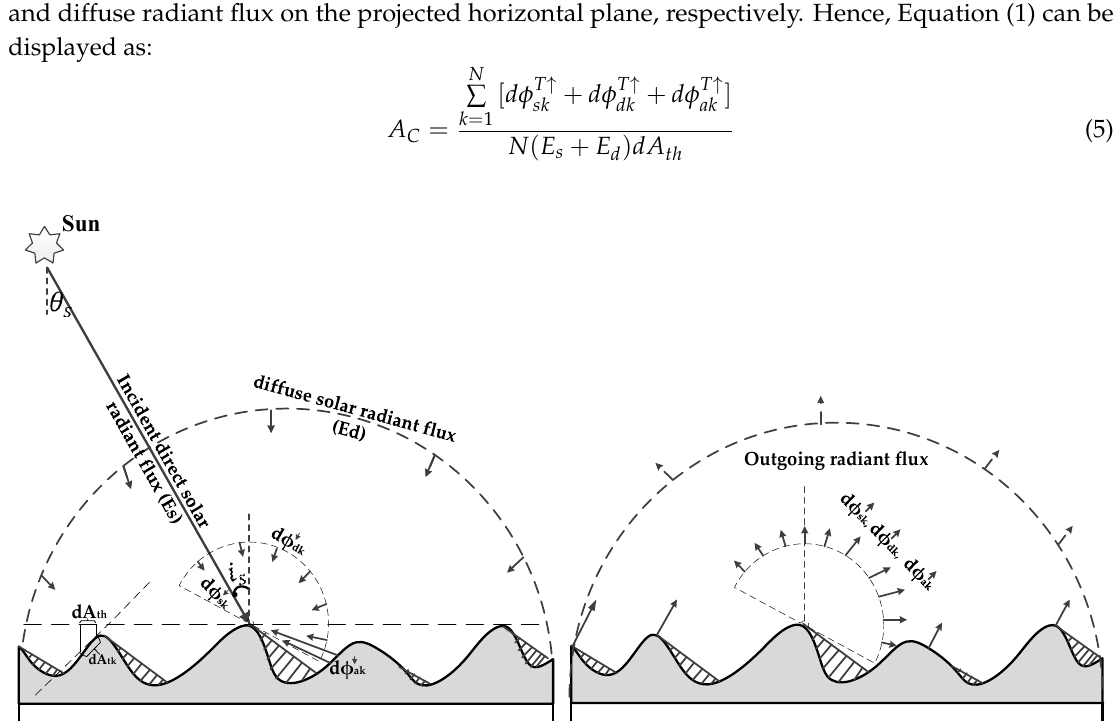
Figure 2. The contributions of incident and outgoing radiant flux over a coarse scale pixel; direct, diffuse and terrain irradiances.